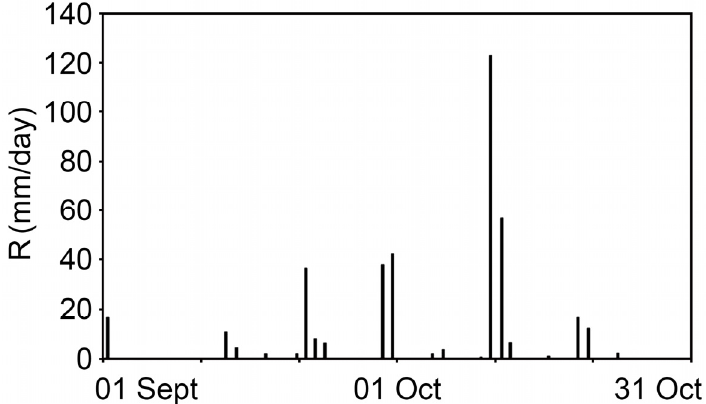
Figure 21. Available rainfall recordings (modified from [55]).